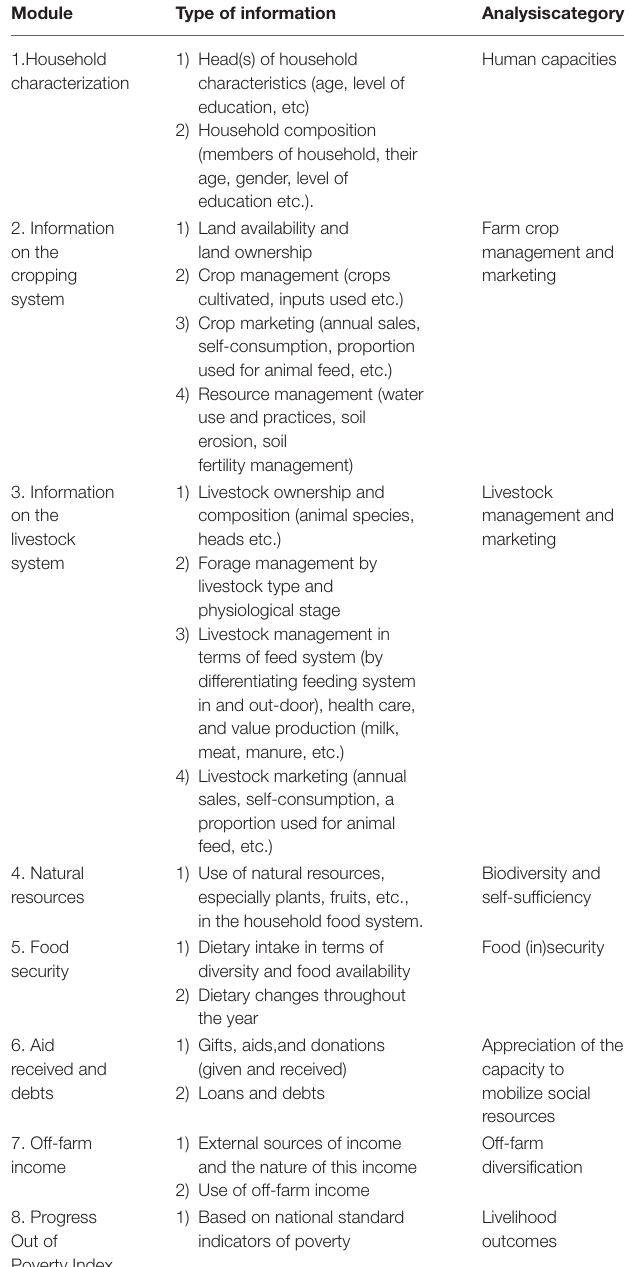
TABLE 1 | Structure and contents of the RHoMIS questionnaire used in Morocco. Module Type of